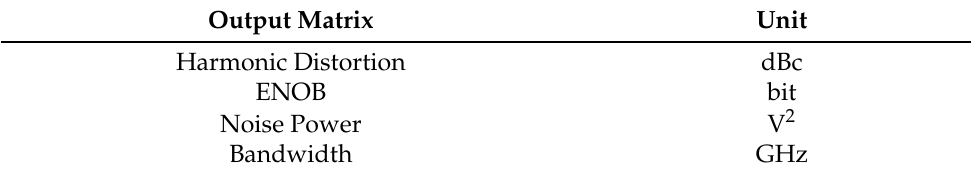
Table 2. Performance output matrix of the T/H